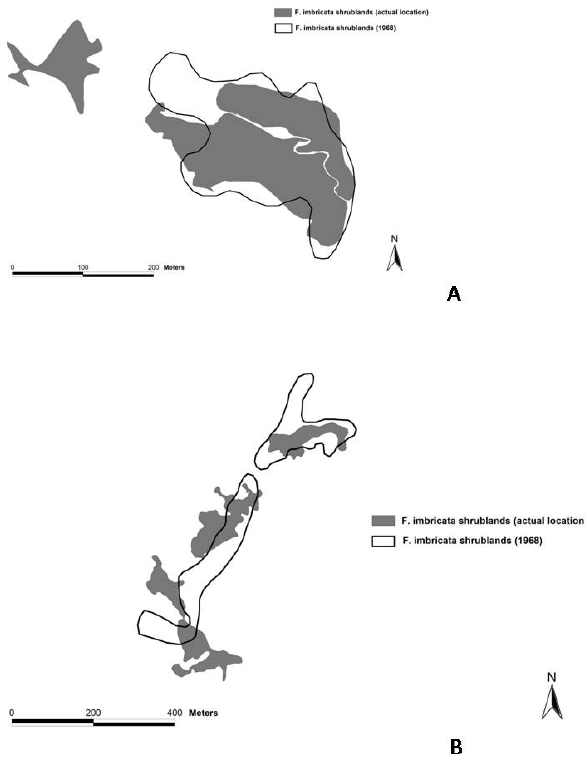
Fig. 6. Temporal change (1968–2009) in the F. imbricata shrub- lands under study. (A) Fire site. (B) Control site.